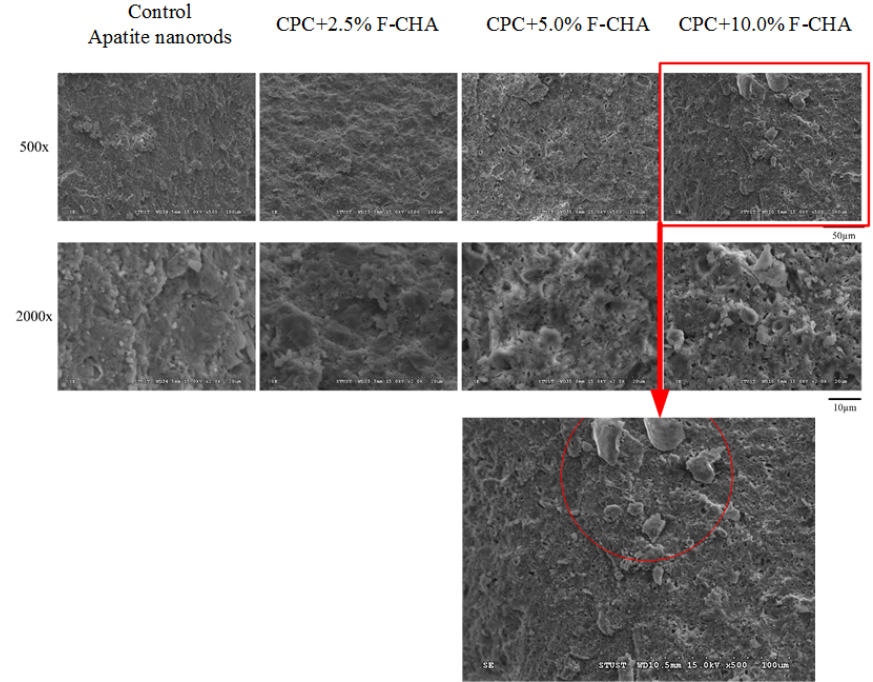
Figure 7. SEM images of fracture surfaces after compressive strength testing. CPC composites with different ratios of ferulic acid-carbonated apatite nanorods were measured after immersion in TBS for 1 day.